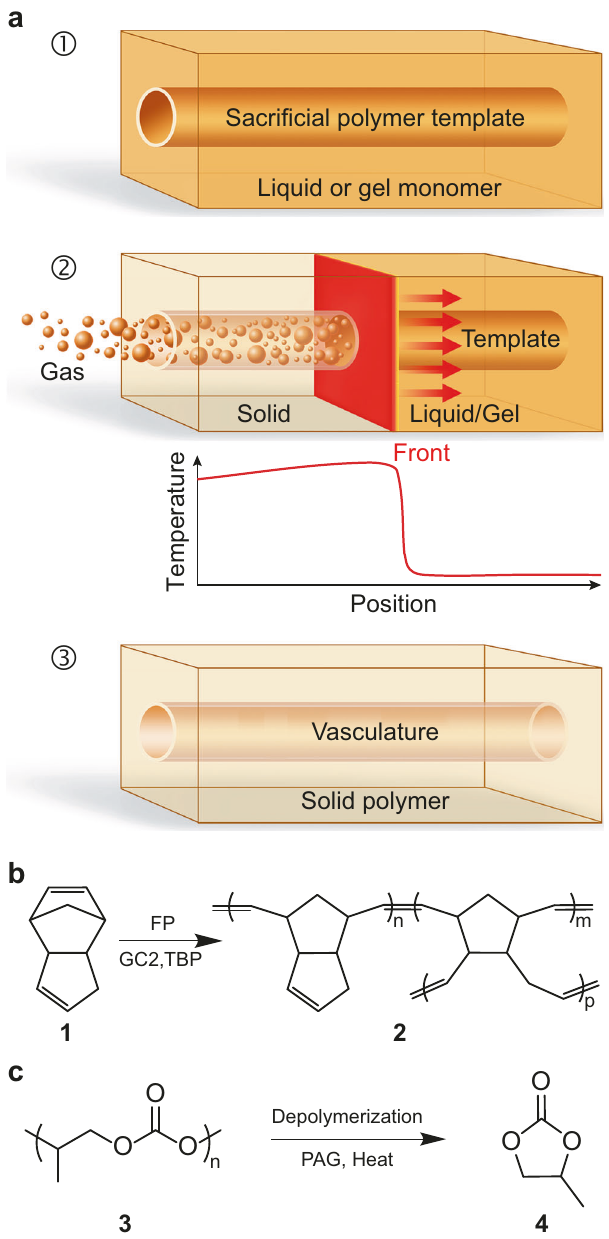
Fig. 1 Overview of synchronized polymerization and vascularization concept. a Schematic representation of the coordinated fabrication of a microvascular structure. ➀ A sacri fi cial polymer template is embedded inside a liquid or gelled host matrix. ➁ A self-propagating exothermic polymerization reaction transforms the host into a solid matrix and concurrently depolymerizes the sacri fi cial template into small molecules through a localized increase in temperature. ➂ A durable thermoset with vasculature mirroring the starting template is manufactured under standard ambient conditions within minutes. b Scheme for FP of DCPD monomer ( 1 ) into crosslinked pDCPD ( 2 ) using a second-generation Grubbs ’ catalyst (GC2) and tributyl phosphite inhibitor (TBP). c Scheme for photoacid generator (PAG) catalyzed thermal depolymerization of PPC ( 3 ) into PC monomer ( 4